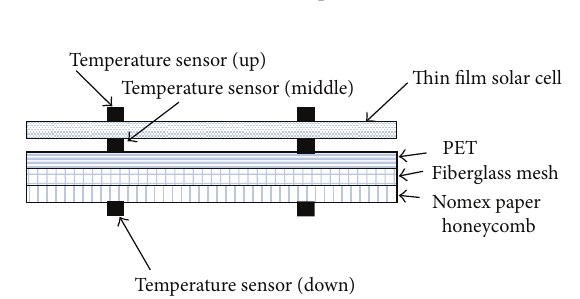
Figure 7: Test specimen 1.